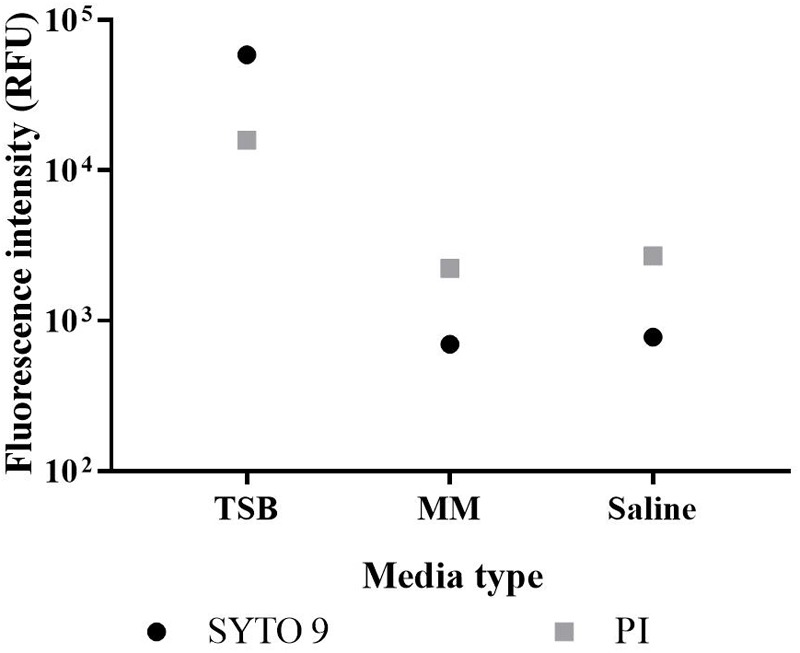
Fluorescence of growth media. TSB, minimal A salts medium with 0.2% glucose (MM), and 0.85% saline (control) were stained with SYTO 9 or PI. Fluorescence intensity was derived from integrating spectra at 505–515 nm for SYTO 9 emissions (circles) and 600–610 nm for PI emissions (squares) with the median value of triplicate readings presented.